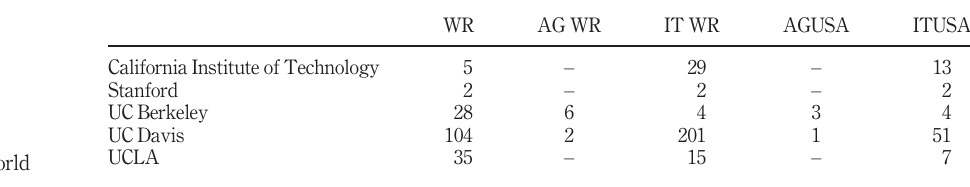
ranking of Californian universities in IT and AG knowledge fi